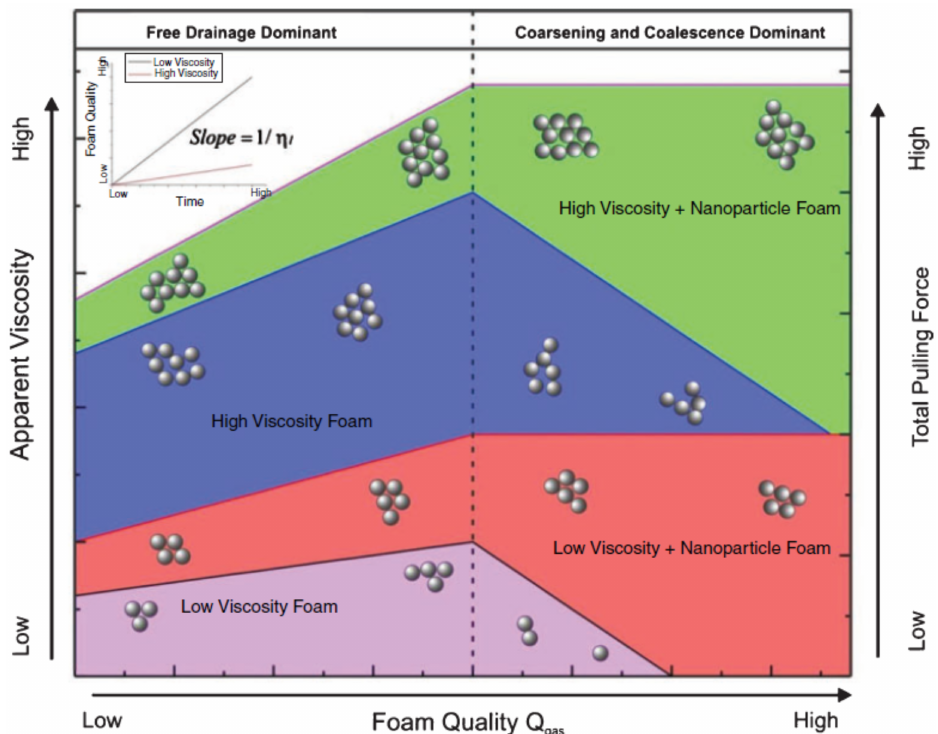
Figure 27. Foam performance against foam quality in two distinct regions (Reprinted with permission from Fei et al. [30]). Copyright, 2018